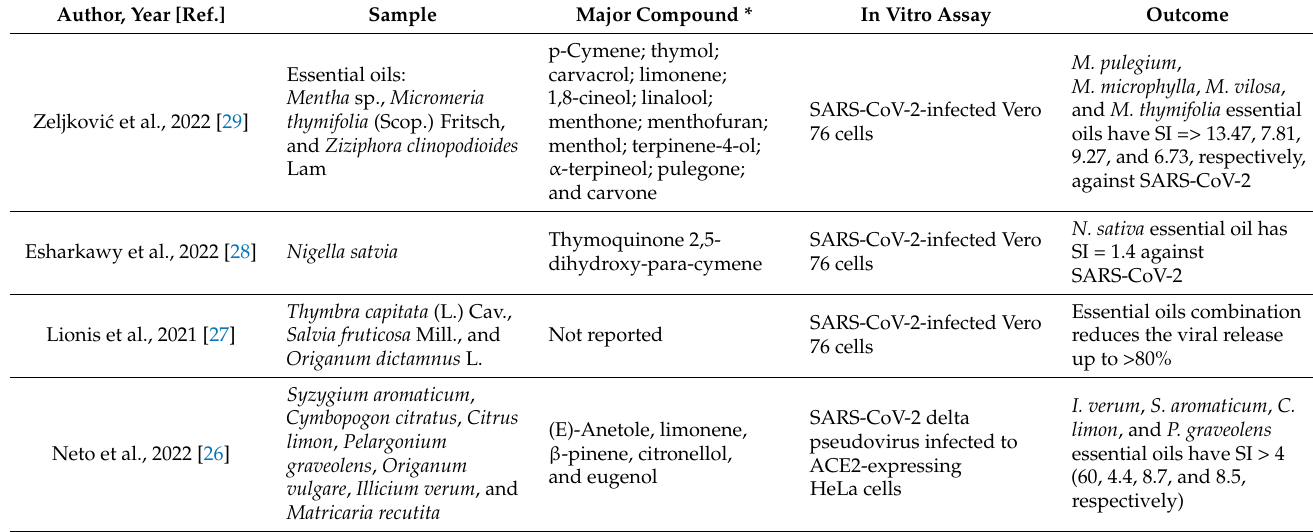
Table 5. Studies reporting anti-SARS-CoV-2 activity of essential oils but without molecular target